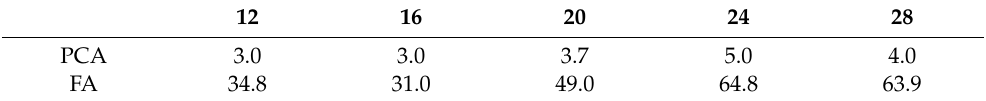
Table 10. Running time (second) of PCA and FA with different number of bands in WHU